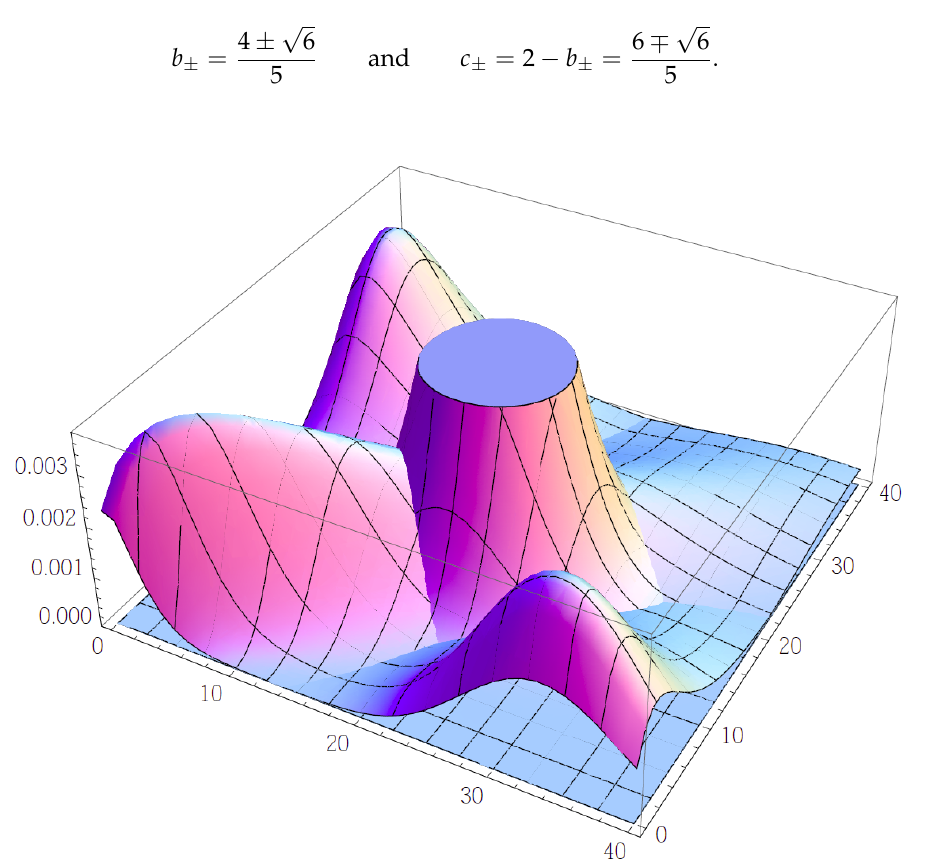
Figure 1. Highly smoothed probability mass functions of the N 2 to Figure 2 for the Poisson case (central truncated graph), the comonotone case (with a hump along the diagonal) and the case of corr ( Λ 1 , Λ 2 ) ≈ − 0.9519 (two symmetric humps near the corners). We take V = R 2 . The (group) claim sizes equal ( 1,0 ) and ( 0,1 ) in these cases, i.e., X s